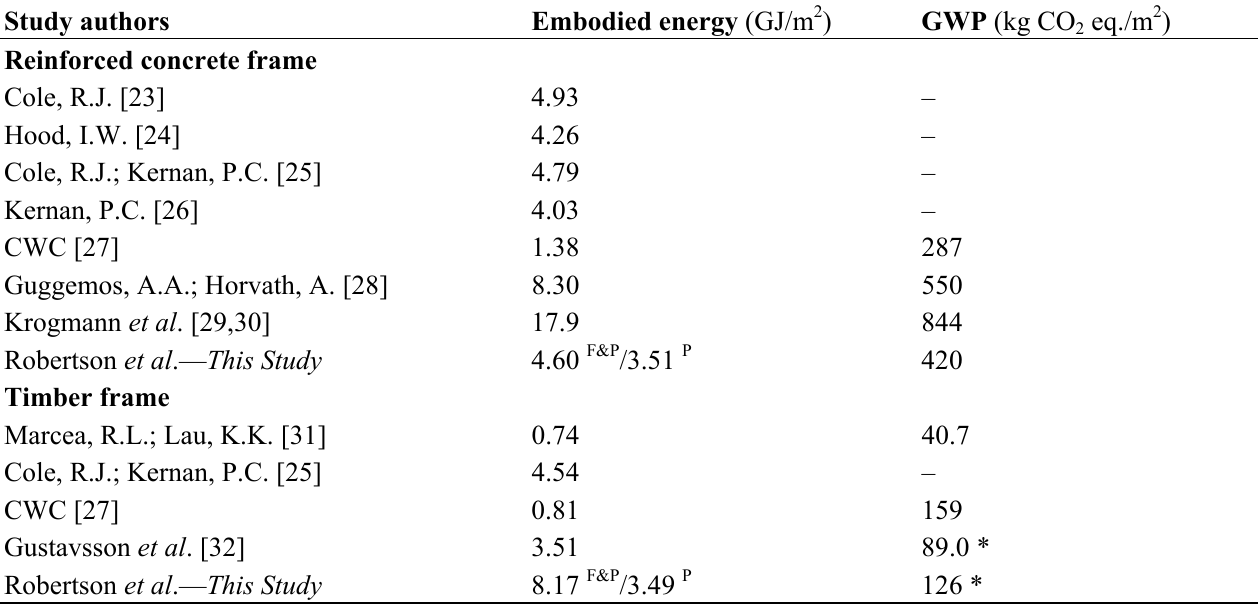
Table 4. Comparison of study results to existing whole building LCA